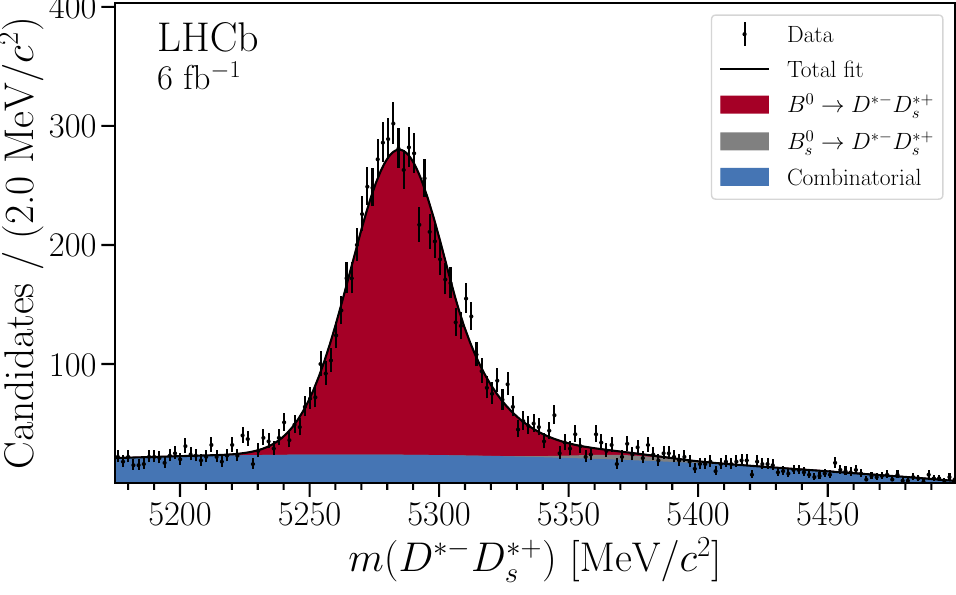
) for selected candidates in data, with the fit overlaid. Figure 3 . Distribution of m ( D ∗− D ∗ + s shev, whereas linear and exponential background models do not describe the background sufficiently